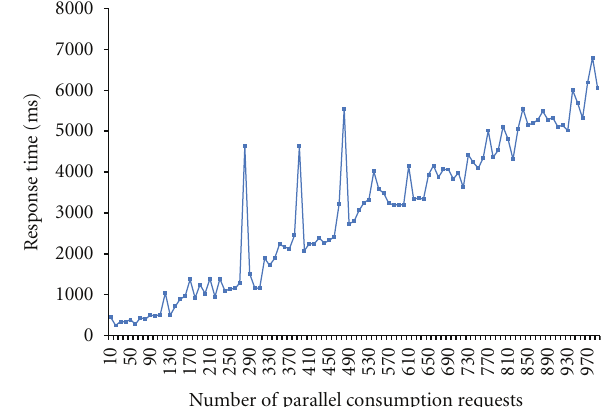
Figure 8: Response time variation according to number of con- sumption requests